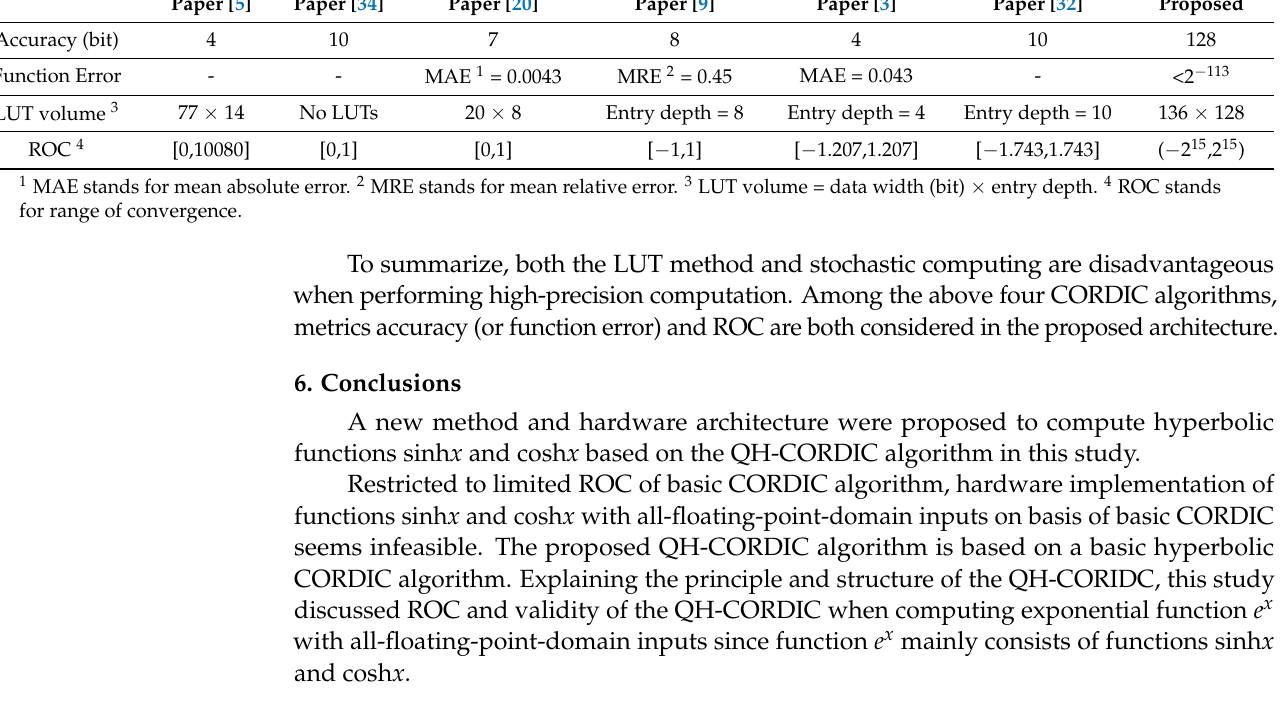
Table 6. Comparisons of LUT, stochastic computing, and CORDIC on high-precision computing. LUT Stochastic Method